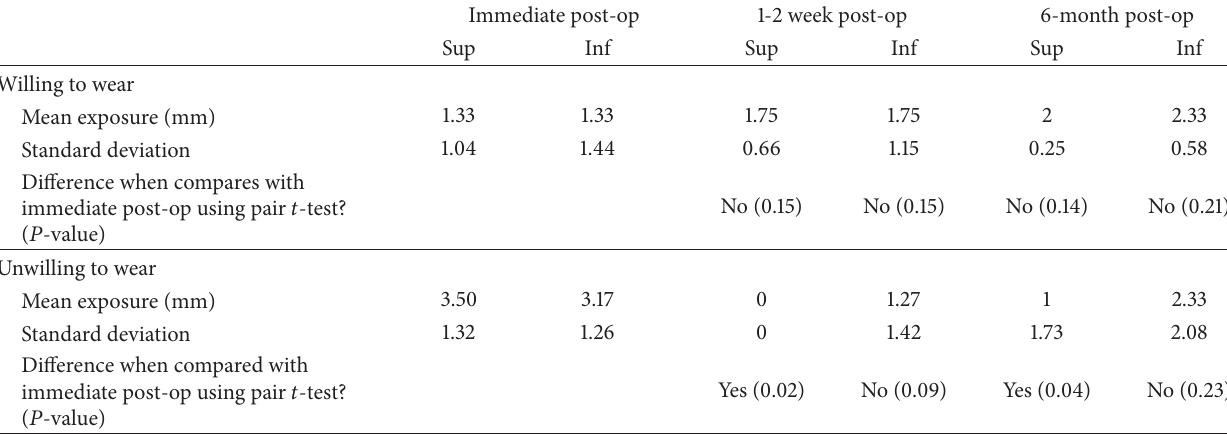
Table 7: Comparison of the clinical abutment exposure in patients willing and those unwilling to wear the ear